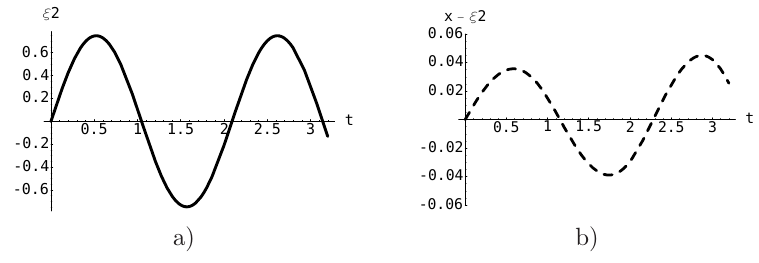
Figure 5. 2 -type solution of the problem (3.9).